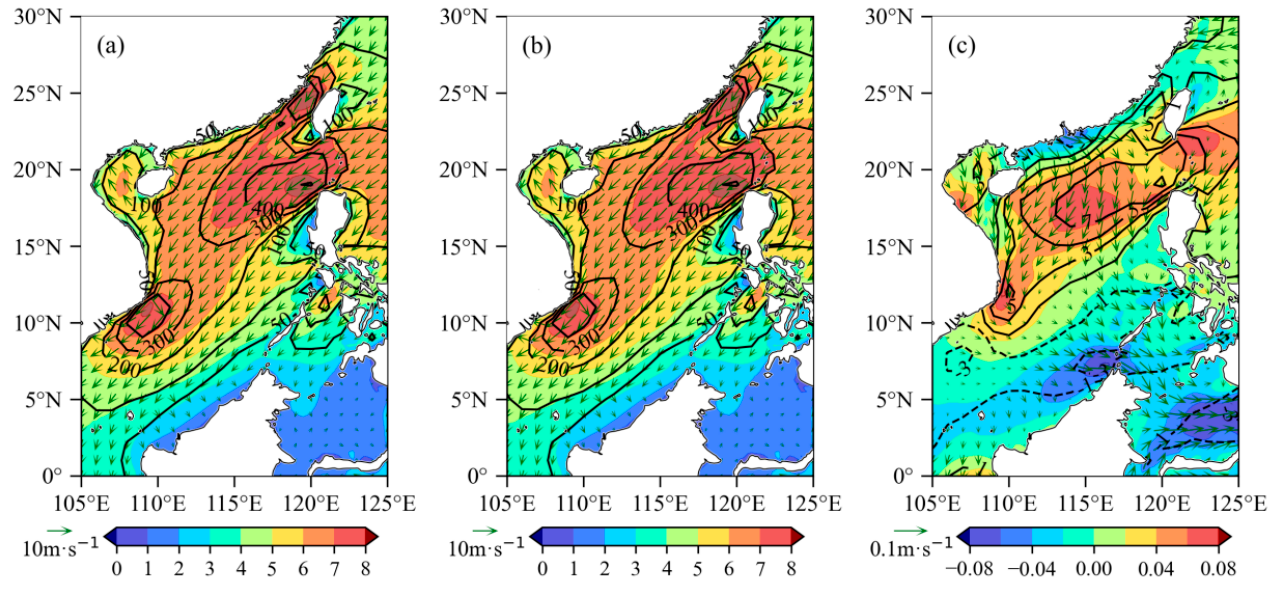
Figure 11. The annual mean distribution of wind (shaded, vector, unit: m · s − 1 ) and wind power density (contour, unit: W · m − 2 ) over the SCS in 2021 ( a ), the next 5 years ( b ), and their differences between the next 5 years and 2021 ( c ).